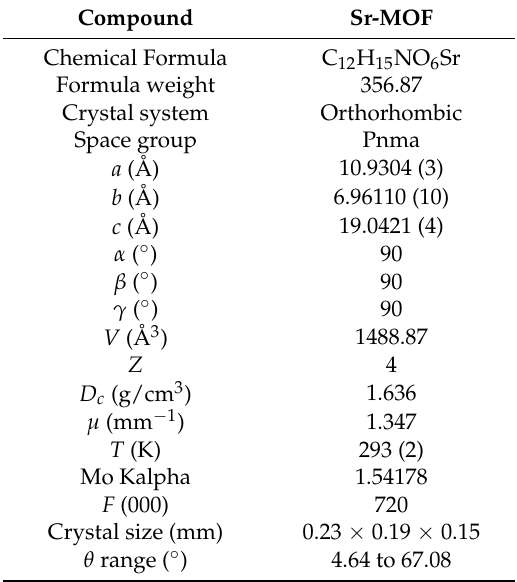
Table 1. Crystal data and structure refinement for